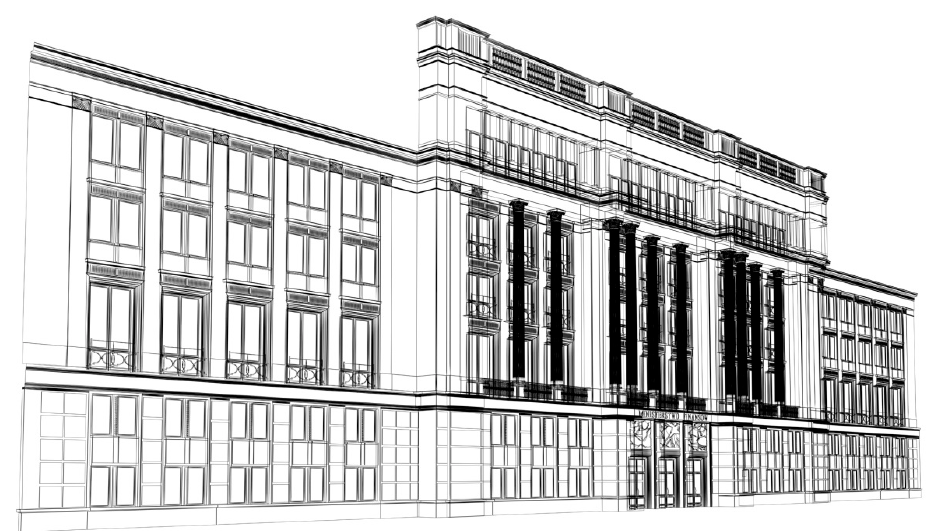
Figure 9. The geometric object model optimised towards the photometric calculations.